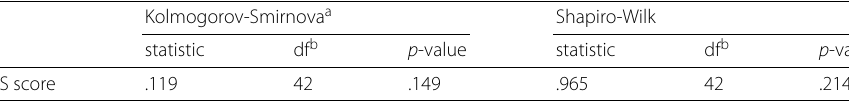
Table 6 Tests of normality Kolmogorov-Smirnova a Shapiro-Wilk statistic df b p -value statistic df b p -value SUS score .119 42